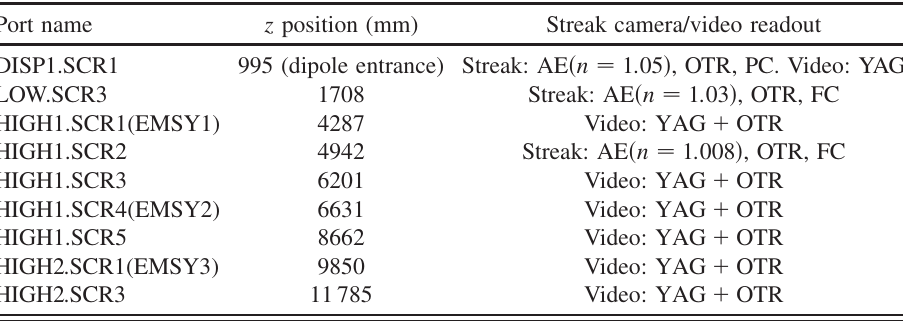
TABLE IV. Characteristics for the screen stations used for the measurement of the longitudinal phase-space distribution and transverse emittance. The table contains the z coordinate of the center of the screen stations, the kind of readout, and the kind of screen or radiator for streak camera and video readout. (FC: full cone, PC: partial cone, AE: silica